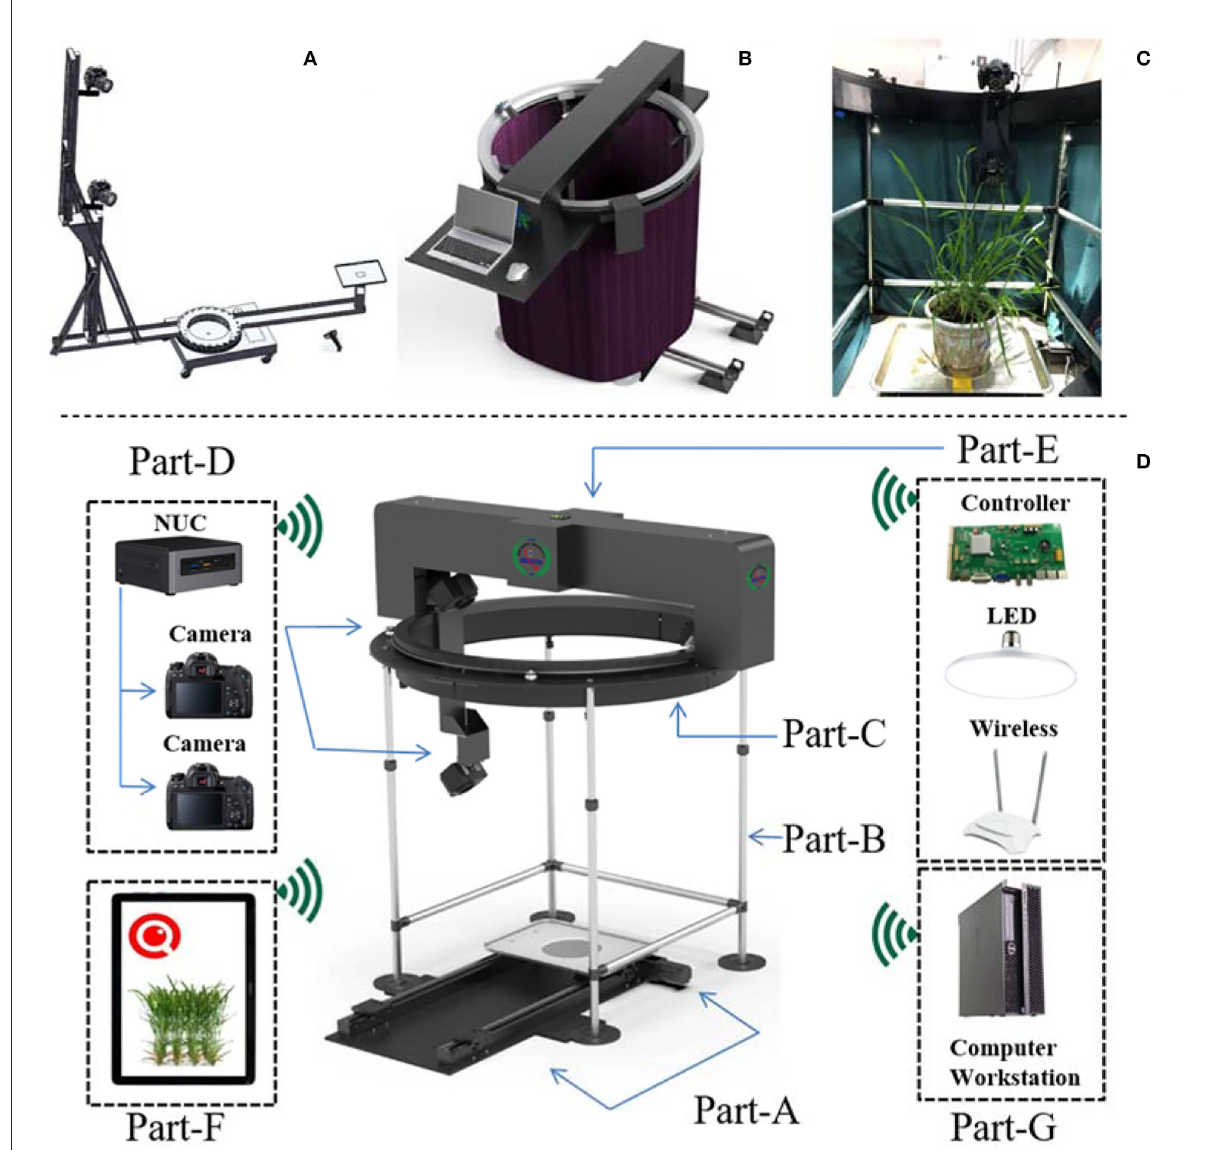
FIGURE2 Hardware of MVS-Pheno V2. (A) Structural composition of MVS-Pheno V1. (B) Overall appearance of MVS-Pheno V2. (C) The actual scene inside the platform when acquiring multi-view images of wheat shoots. (D) Detailed hardware composition of MVS-Pheno V2